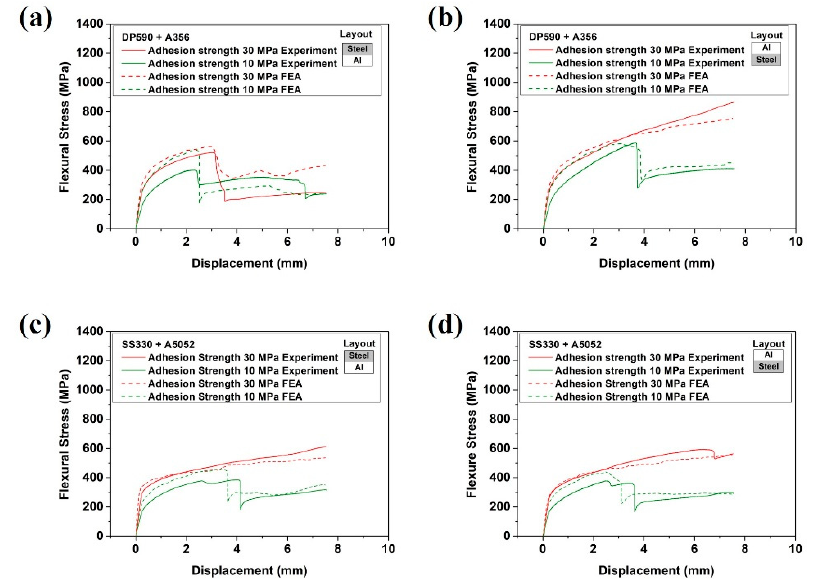
Figure 14. Flexural stress–displacement curves obtained by the FEA: ( a ) DP590 (upper)–A356 (lower), ( b ) DP590 (lower)–A356 (upper), ( c ) SS330 (upper)–A5052 (lower), and ( d ) SS330 (lower)–A5052 (upper).